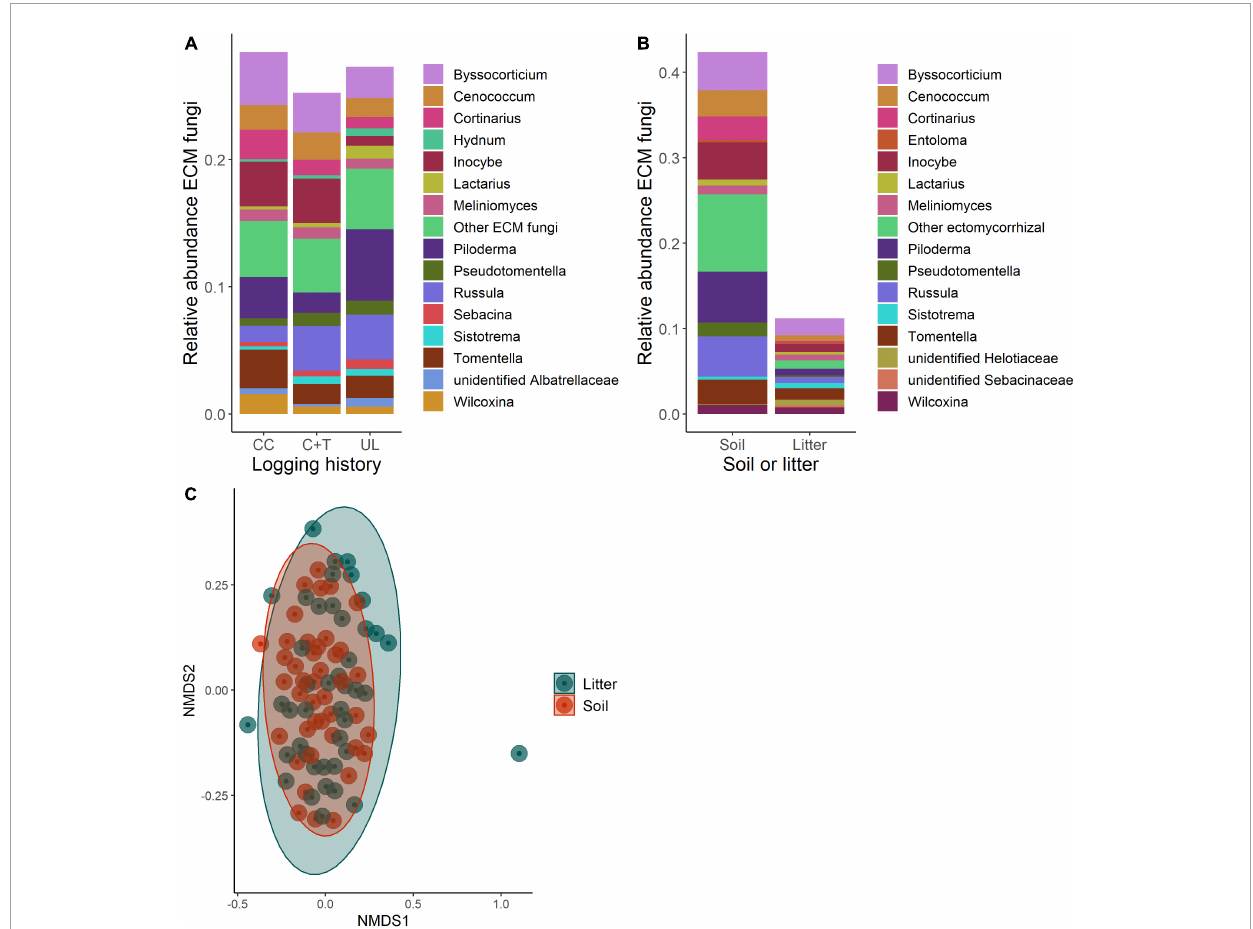
FIGURE3 Comparisons of ectomycorrhizal fungal (ECM fungi) communities in soil and litter of logged and unlogged forest stands within the H. J. Andrews Forest, Oregon, USA. Clearcut (CC), watershed 6, canopy + thinned (C + T), watershed 7, unlogged (UL), watershed 8. (A) Relative abundances of ECMF genera between watersheds. (B) Relative abundances of ECMF genera between soil and litter. (C) NMDS ordination of ECMF communities based on Bray-Curtis dissimilarities between soil and litter (PERMANOVA, p = 0.578).